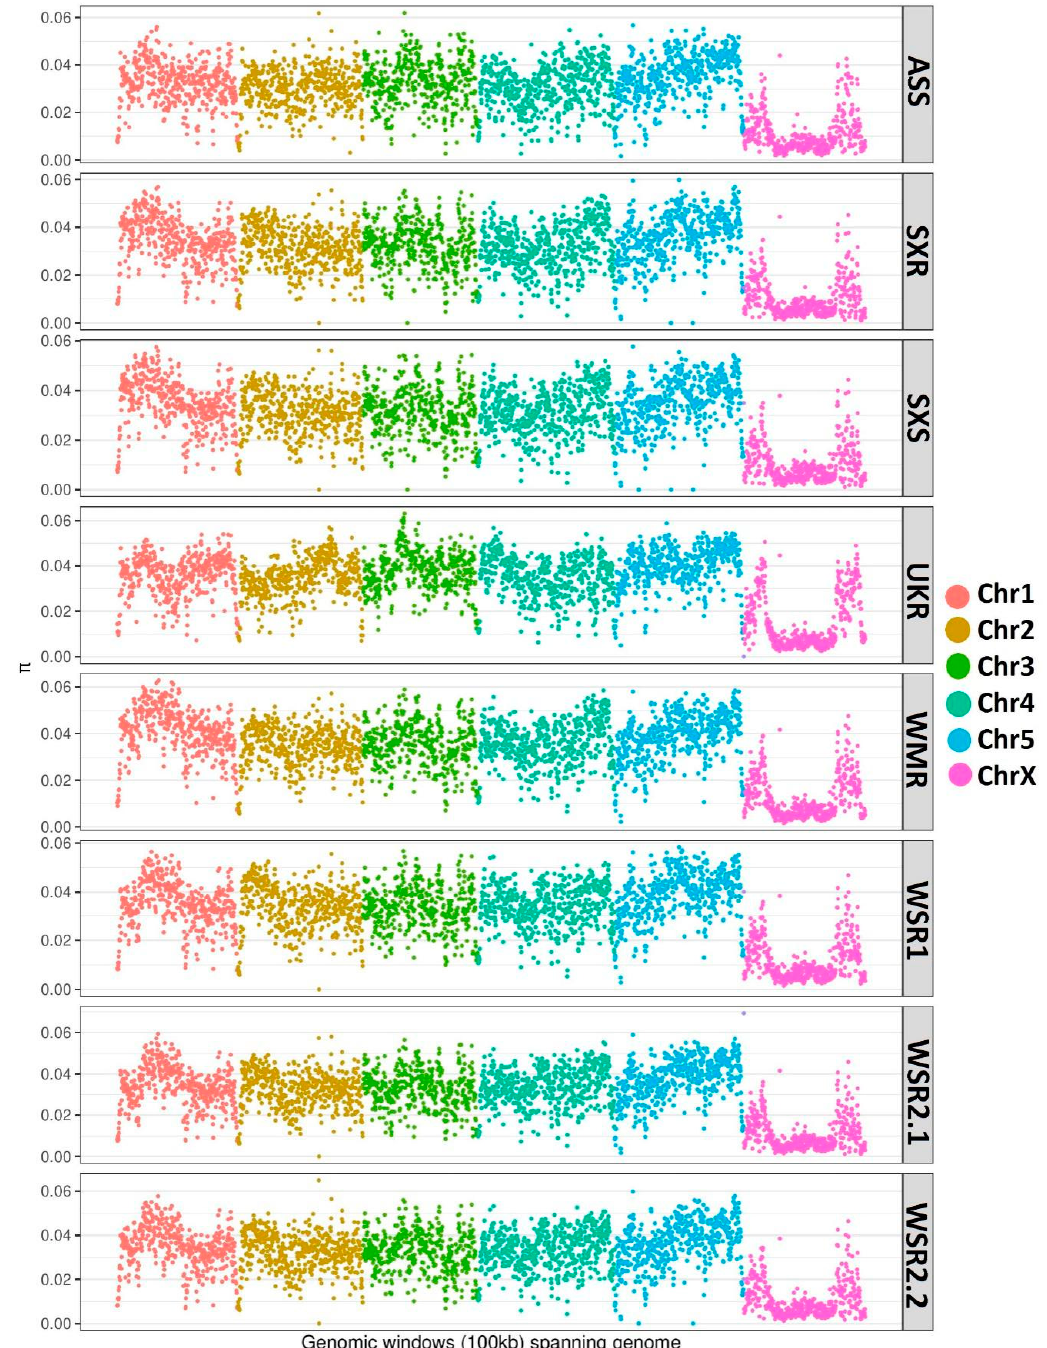
Figure 3. Mapping of within-strain genetic diversity across the genome in all the populations analyzed in the present study. The nucleotide diversity (pi) was calculated in 100 kb windows across the genome and mapped genome-wide in all the populations.